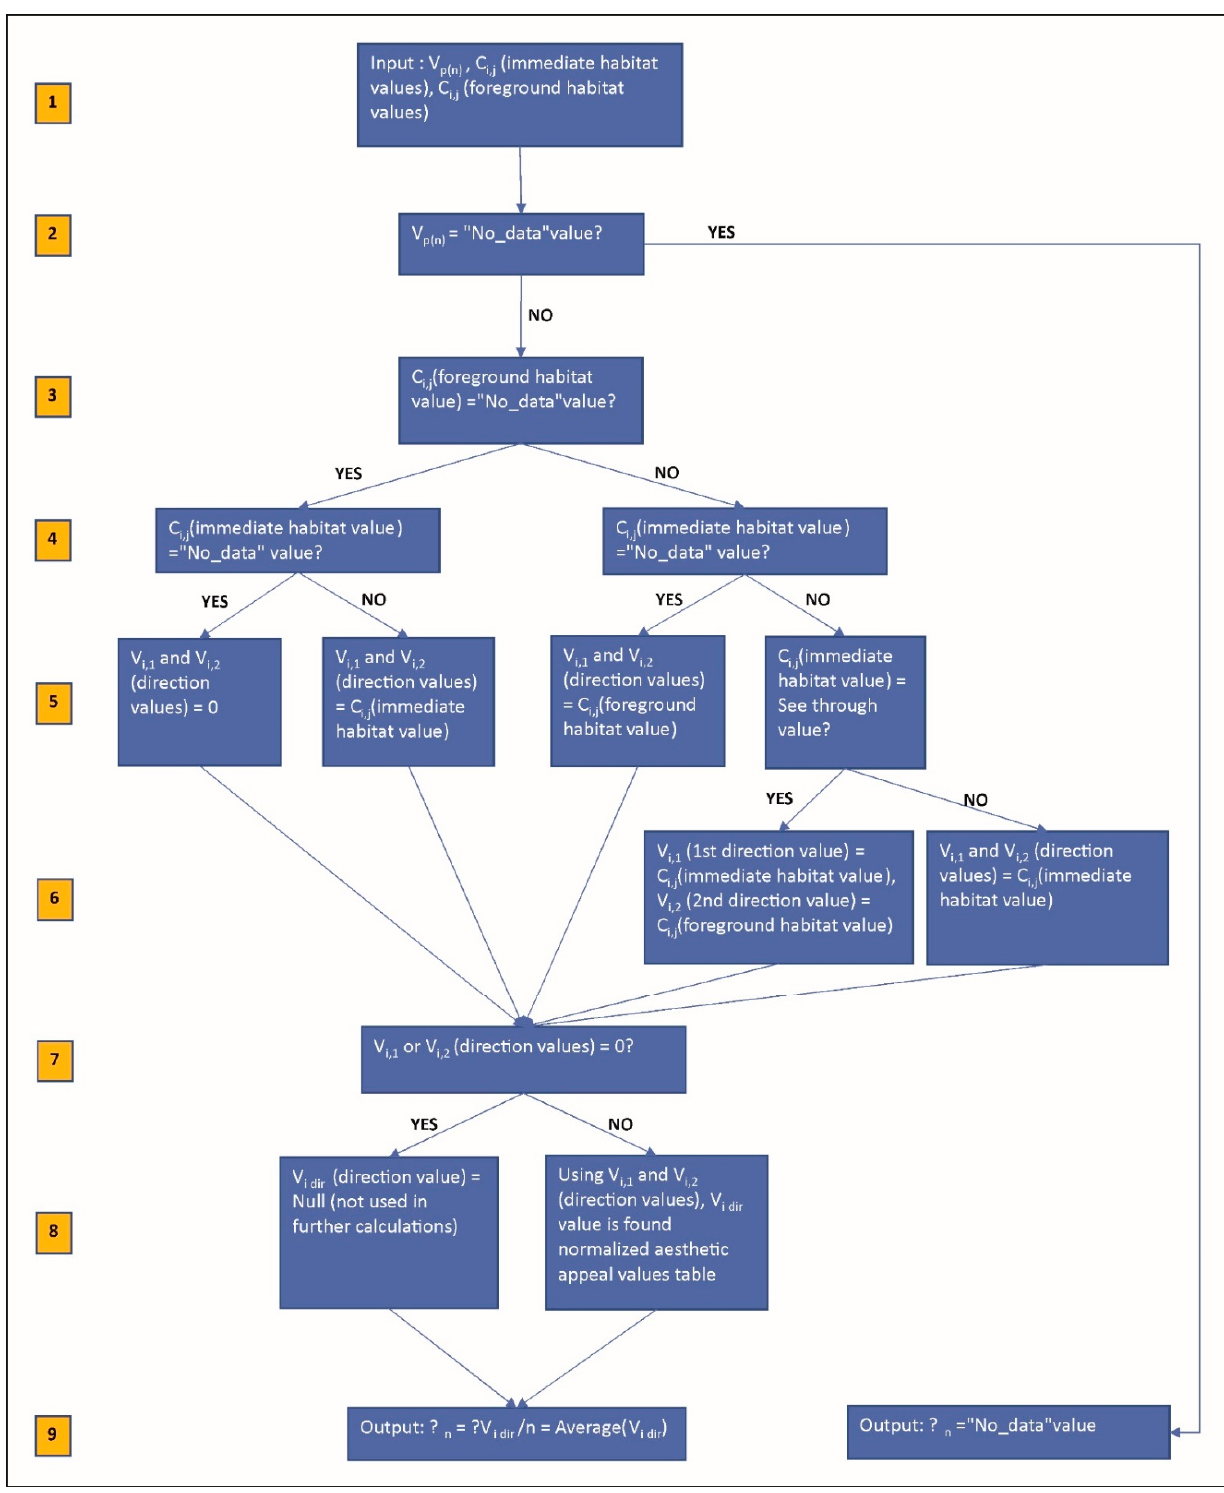
Figure 5. A GIS ‐ based algorithm for computing values of the Aesthetic Appeal Index for a Short ‐ Range Viewshed ( ǣ ). Figure 5. A GIS-based algorithm for computing values of the Aesthetic Appeal Index for a Short-Range Viewshed ( ¯æ ). (Drawn by Domantas Urbis). (Drawn by Domantas